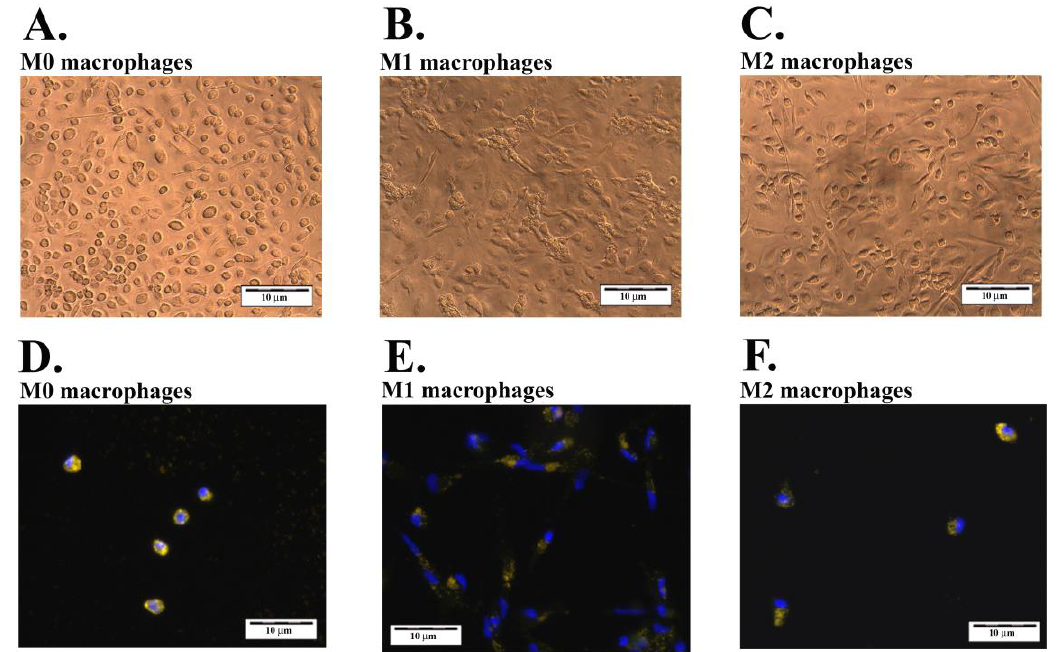
Figure 1. Phase contrast ( A – C ) and fluorescence ( D – F ) microscopy images of differentiated and po- larized macrophages at 200 × magnification. ( A , D ): quiescent M0 macrophages; ( B , E ): inflammatory M1 macrophages; ( C , F ): alternatively activated M2 macrophages. After differentiation and polarization at day 5, conditioned media from differentiated and polarized macrophages were analyzed regarding their cytokine content by ELISA.